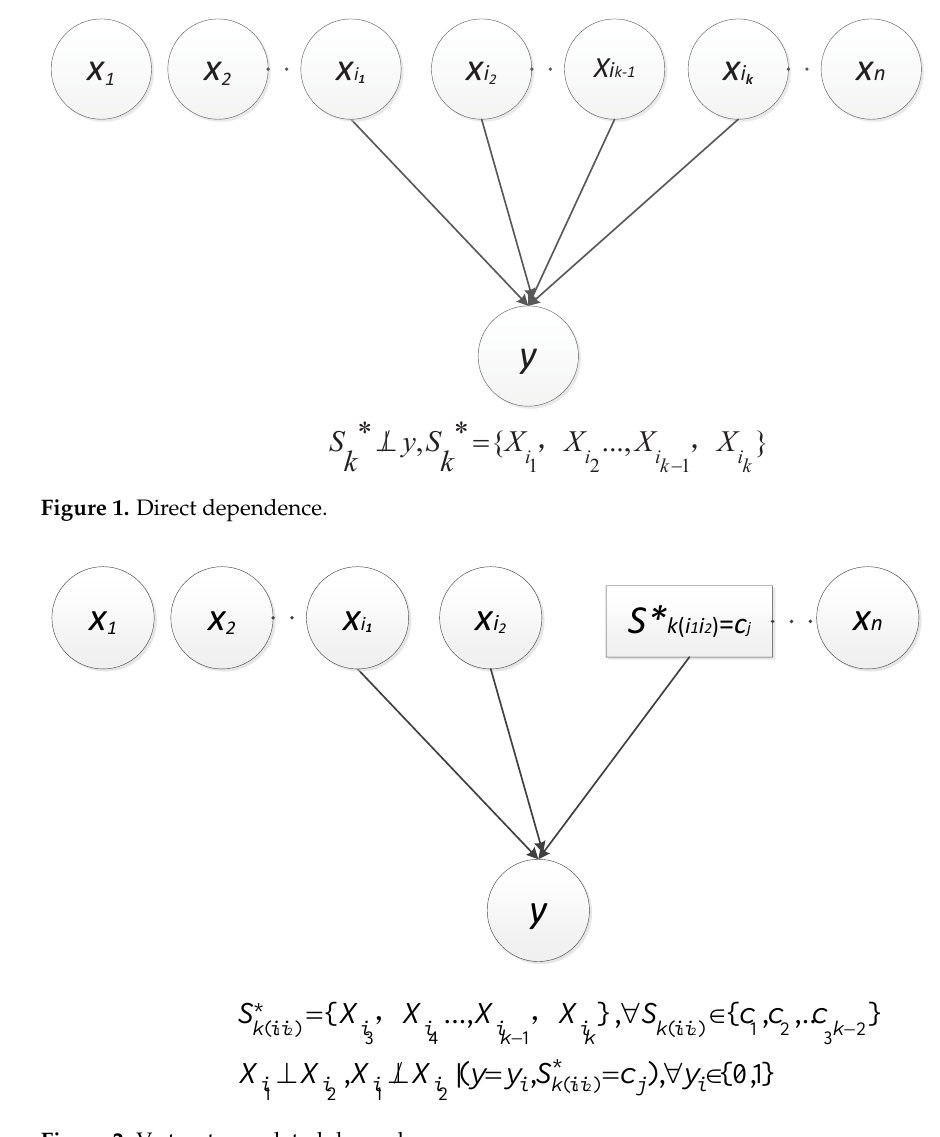
Figure 2. V-structure-related